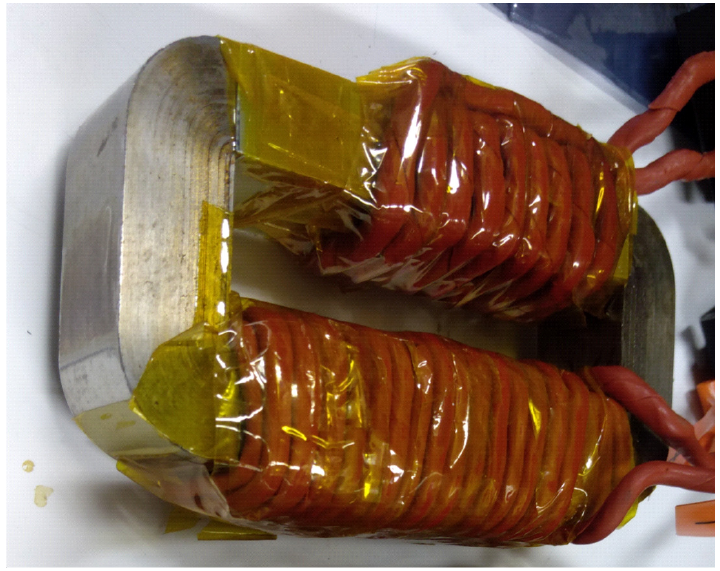
Figure 15. Transformer used in DAB